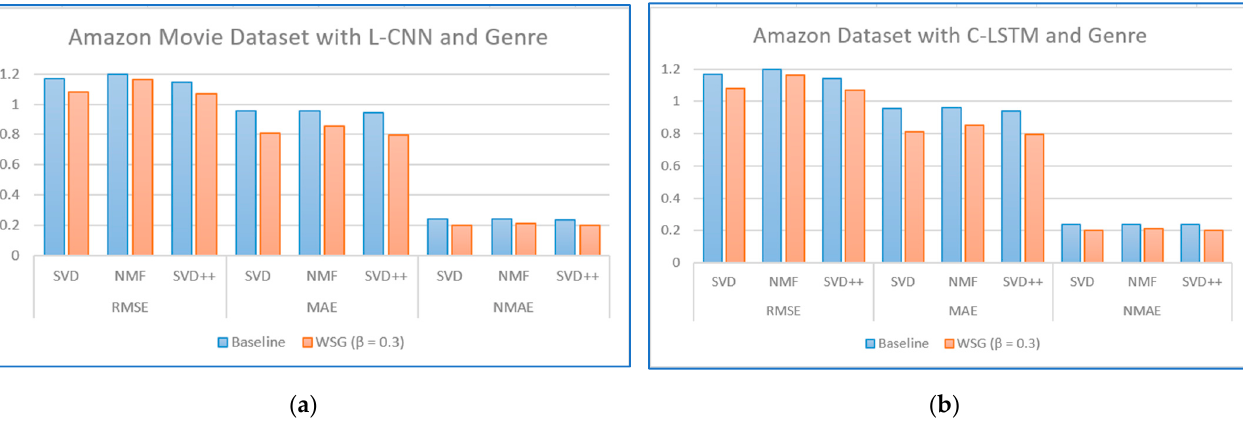
Figure 13. Comparison of the sentiment and genres-based model applied with 𝛽 = 0.3 against baseline on Amazon Movie dataset: ( a ) hybrid LSTM–CNN model in the first panel; ( b ) hybrid CNN–LSTM model in the second panel.